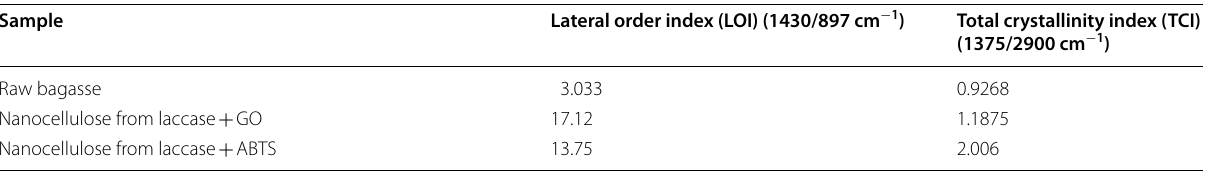
Table 3 Lateral order index (LOI), total crystallinity index (TCI), from FT-IR analysis